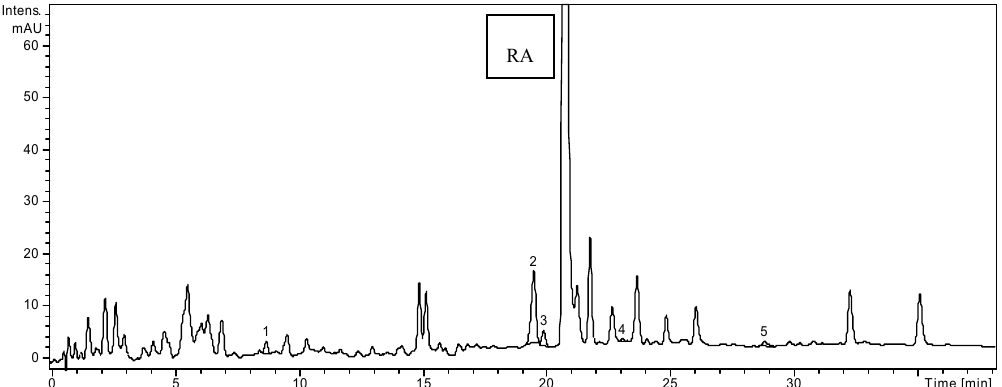
Figure 3. HPLC chromatogram of T.